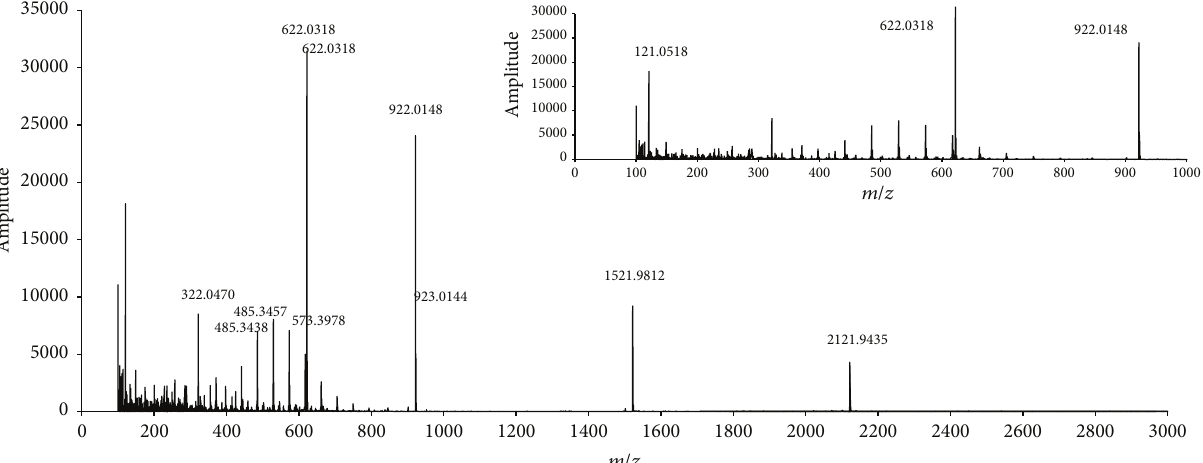
Figure 6: Mass spectrum of the DOM of size less than 0.45 𝜇 m obtained from point 1. Spectrum registered with DSA-TOF-MS.